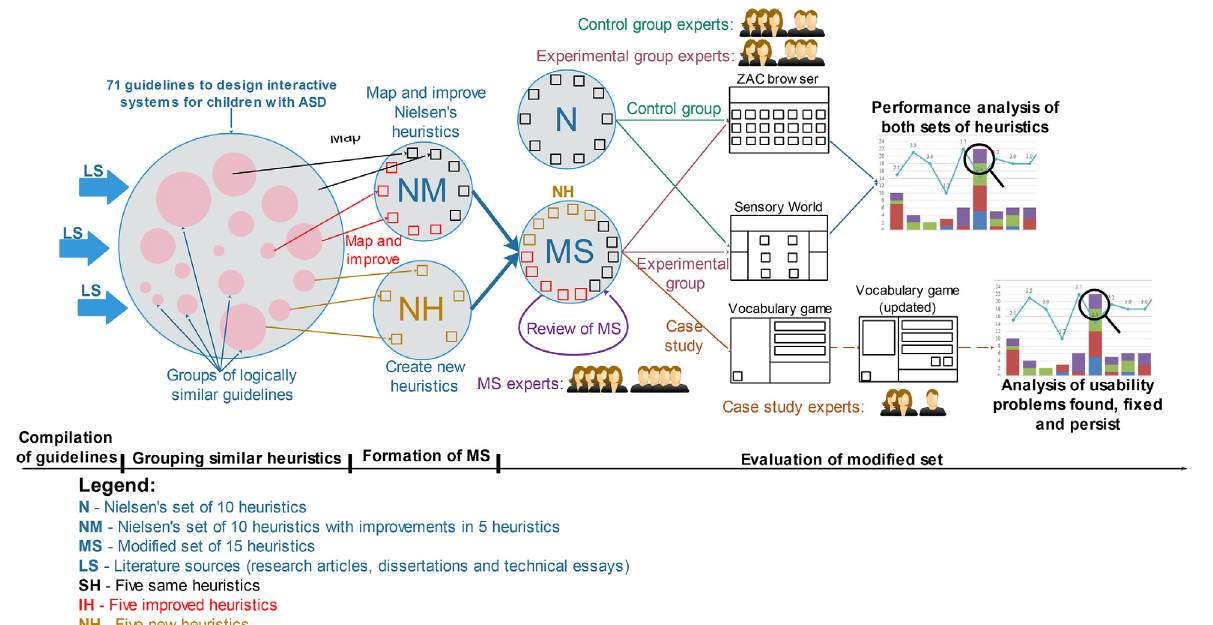
Fig 1. Processes carried out to develop heuristics for the evaluation of interactive systems for children with